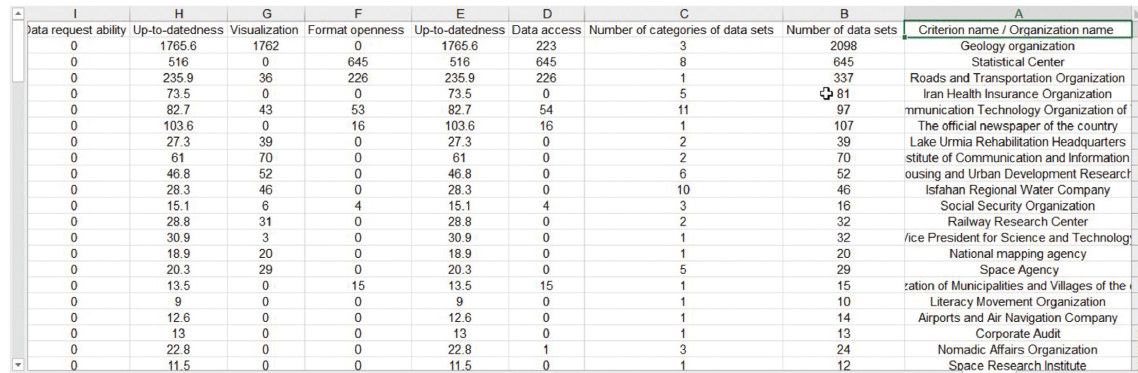
Figure 4: View of the extracted data of organizations based on each criterion.